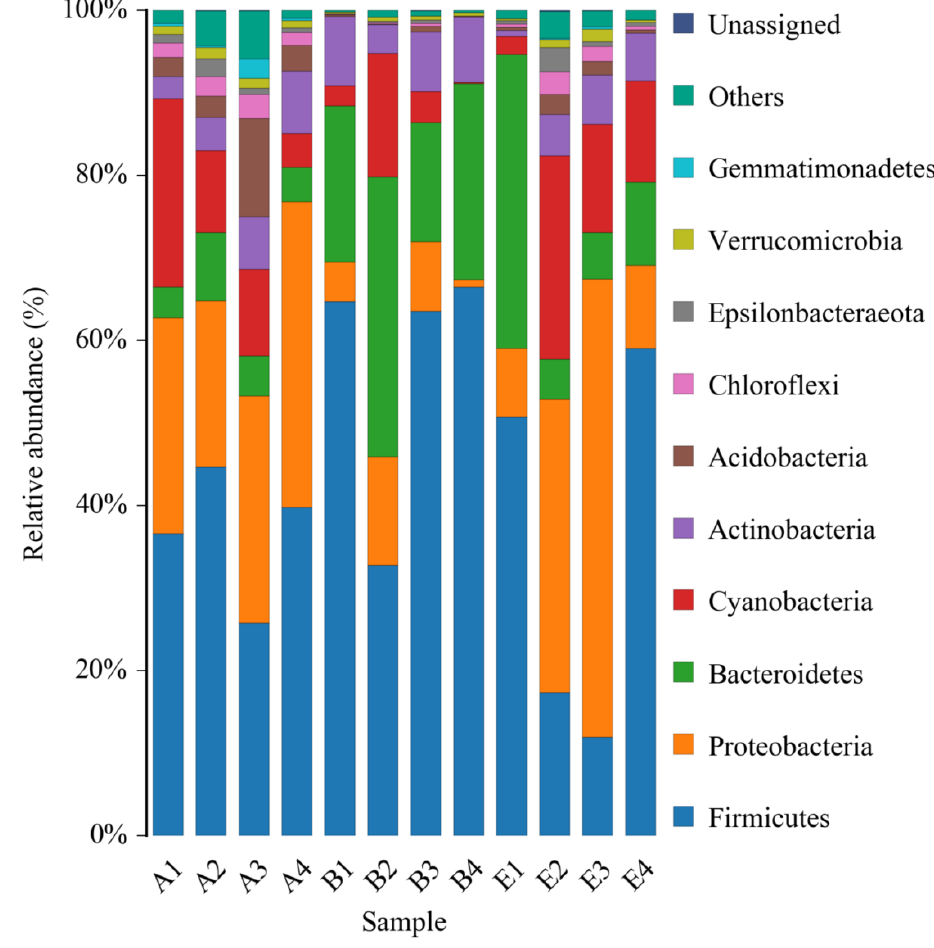
Figure 7. Relative abundance of bacterial phyla of the normal rats, untreated diabetic rats and diabetic rats treated by high dose DC-5 (10 mg/kg body weight) for 30 days. Where, A1 – A4: normal rats; B1 – B4: untreated diabetic rats; E1 – E4: diabetic rats treated by high dose DC-5.